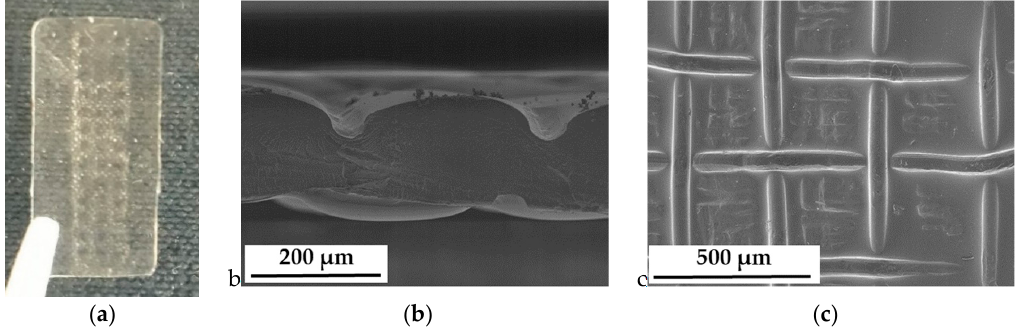
Figure 8. Indentations of the Pt mesh into the electrolyte membrane; ( a ) Nafion 117 after disassembly; ( b ) SEM micrograph of a cross section; and ( c ) SEM micrograph of the electrolyte surface.